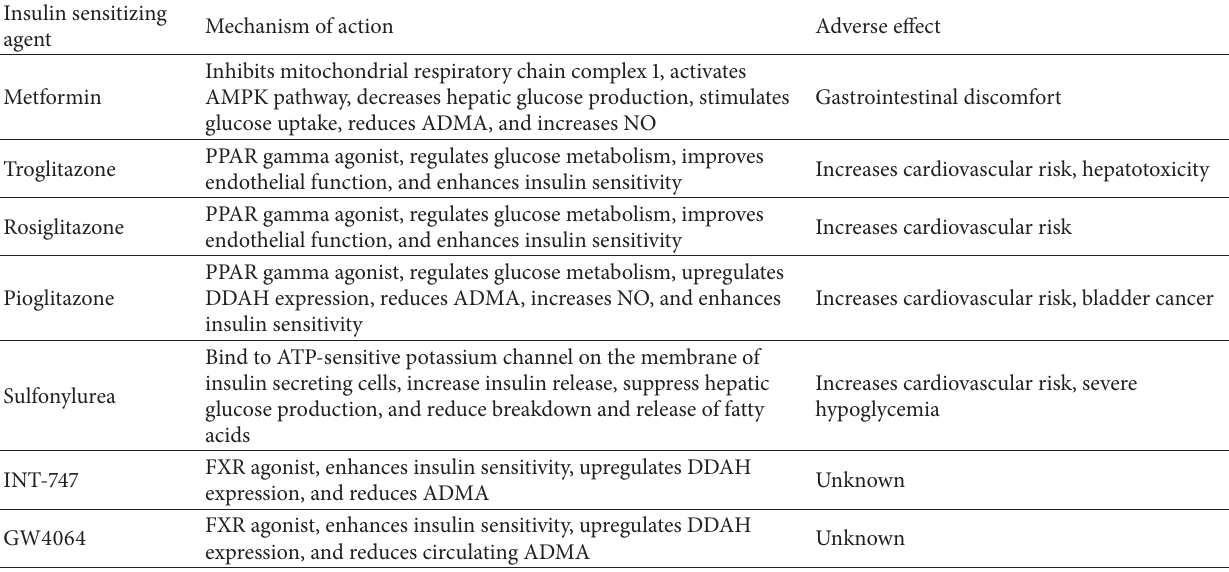
Table 1: Insulin sensitizing agents, their mechanisms of action, and associated adverse events.